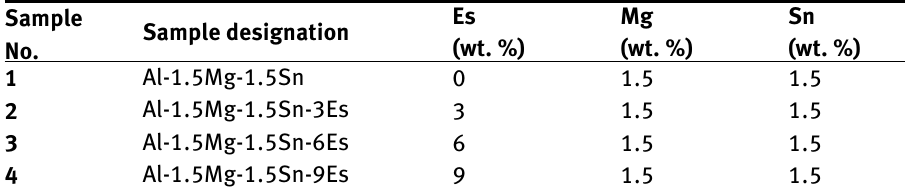
Table 1: Sample designation and reinforcement weight